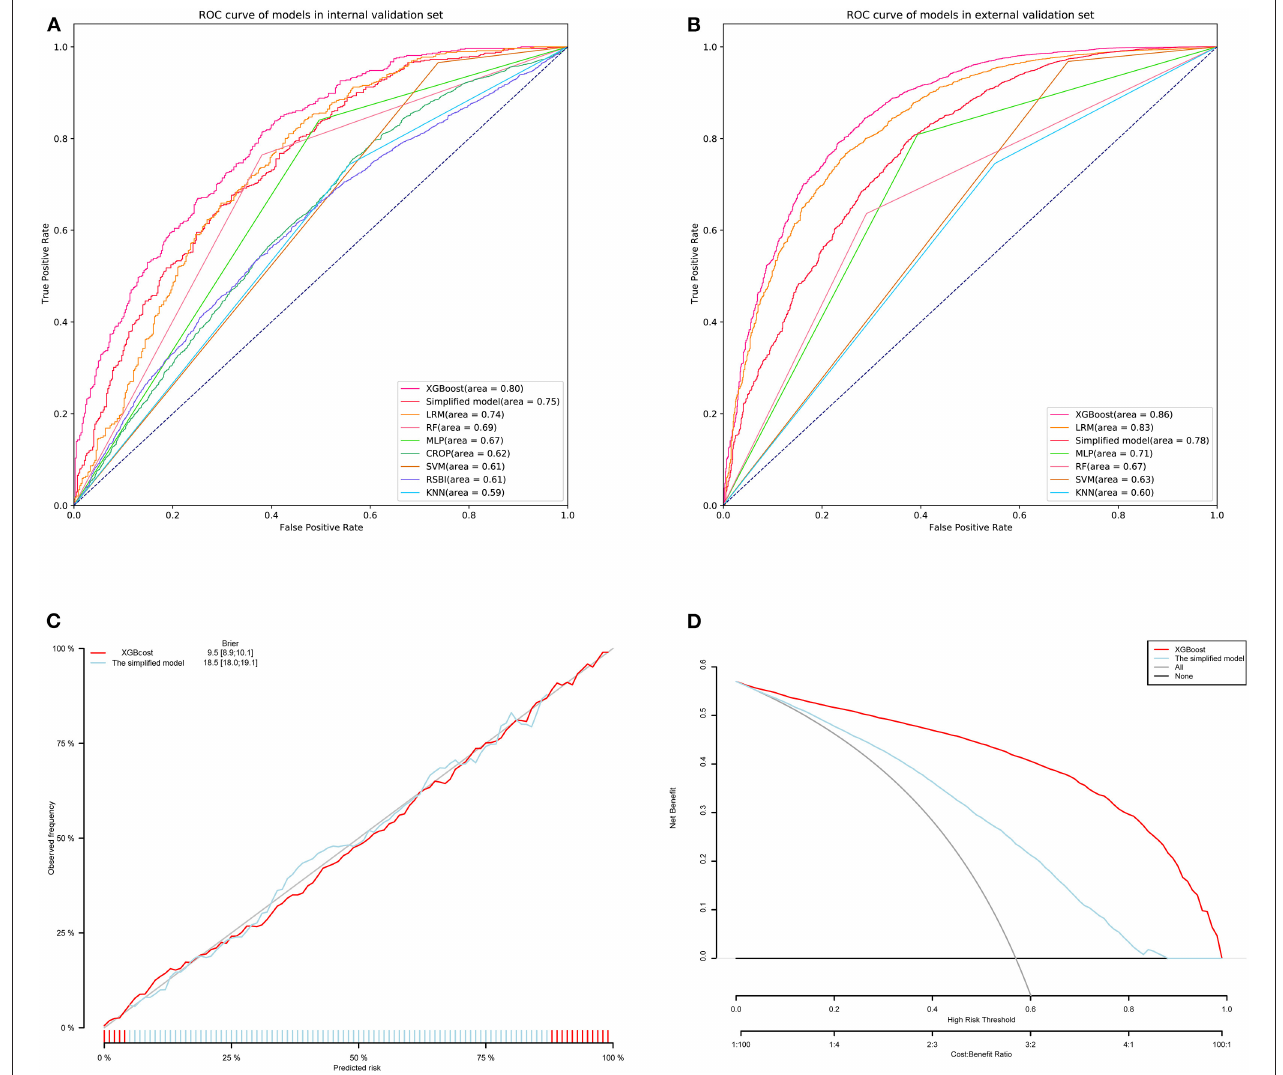
FIGURE 4 | Receiver operating characteristic curves (ROCs) of the XGBoost, LRM, RF, MLP, SVM, KNN, and simplified model. (A) Internal validation set. (B) External validation set. (C) Decision curve analysis of the XGBoost and simplified model. (D) Calibration curve of the XGBoost and simplified model. XGBoost, eXtremely gradient boosting; KNN, KNearest neighbor; MLP, multi-layer perceptron; RF, random forest; SVM, support vector machine; LRM, logistic regression; RSBI, rapid shallow breathing Index; CROP, compliance, oxygenation, respiratory rate, pressure